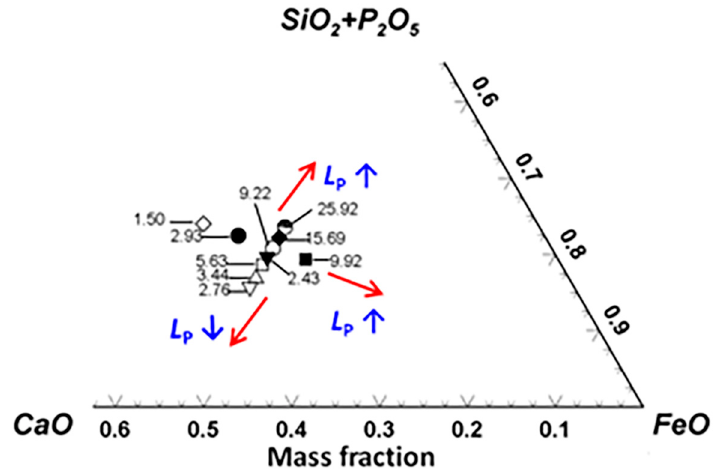
Figure 8. Slag composition and its corresponding L P value in the CaO-(SiO 2 + P 2 O 5 )-FeO pseudo ternary composition diagram.